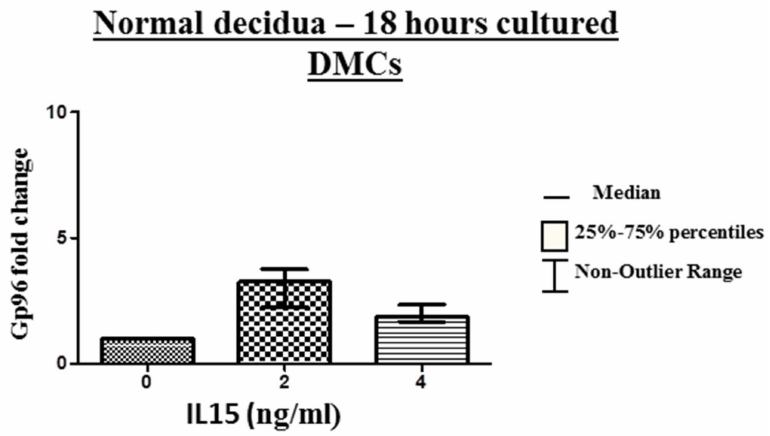
Figure 7. Gp96 mRNA expression in freshly isolated decidual mononuclear cells (DMCs) of normal pregnancy (NP), blighted ovum (BO), and missed abortion (MA). The results are expressed as fold changes of gp96 mRNA levels of BO and MA relative to vehicle control.